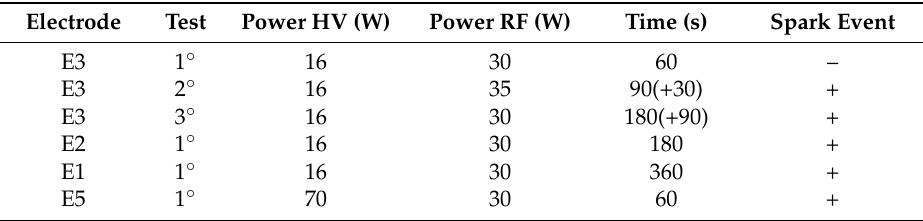
Table 1. Low-temperature atmospheric plasma trials on CuWNEE. Gas flow Ar 10 L min − 1 0.5% H 2 and distance from the torch 2